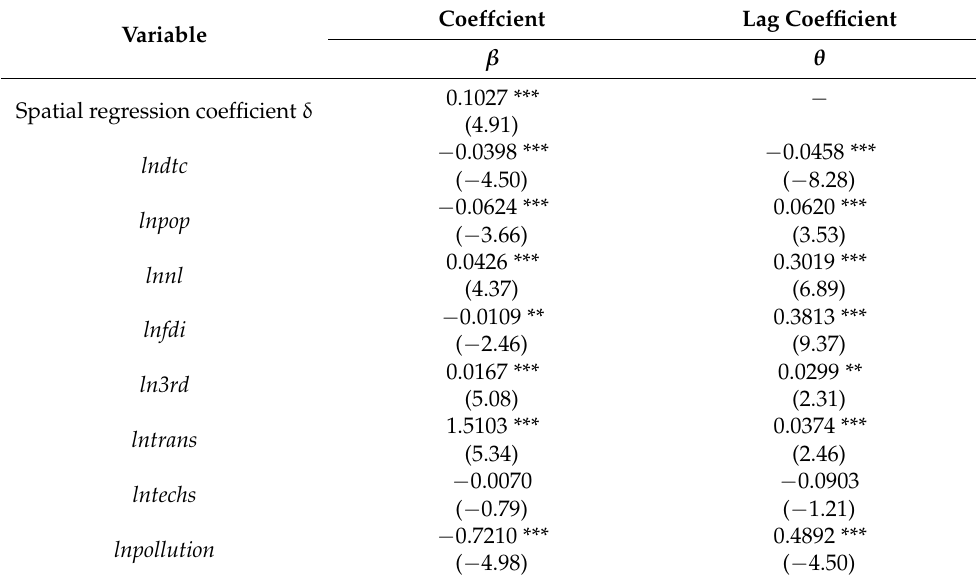
Table 5. Results of the